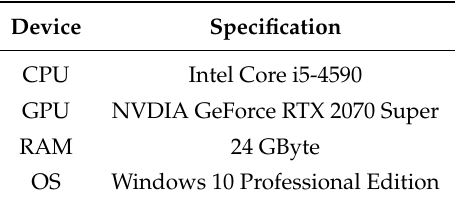
Table 1. Game engine driven device